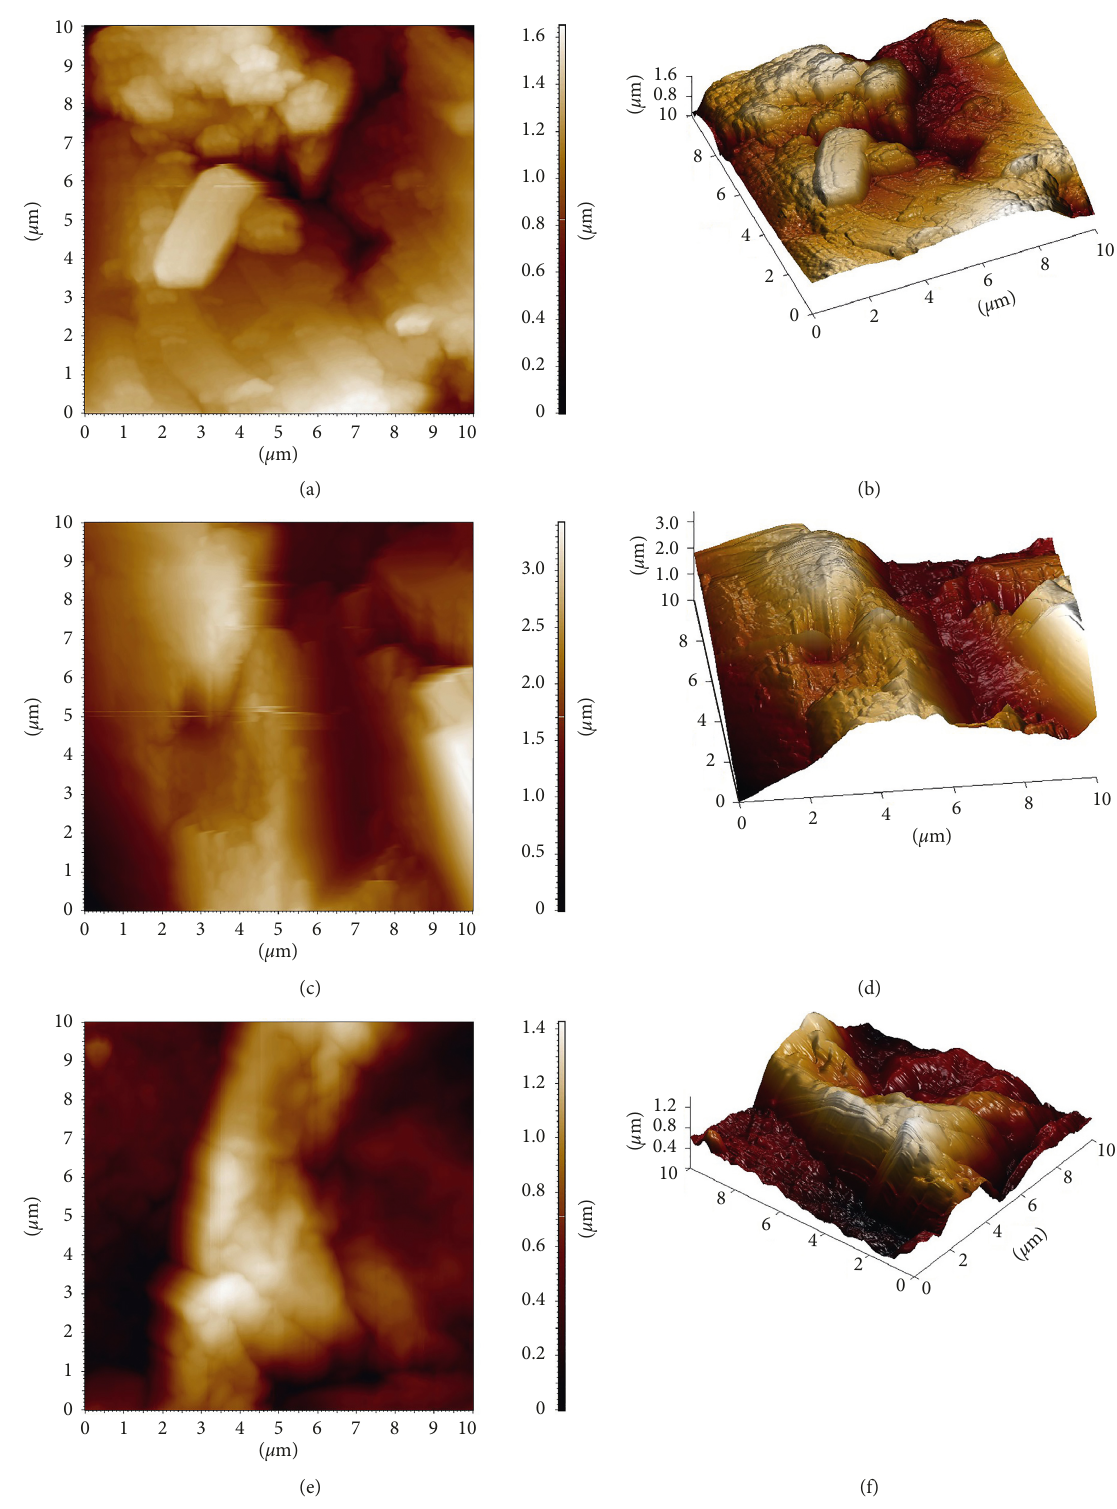
Figure 4: The AFM 2D (on the left) and 3D topography images (on the right) of specimen 100 (a, b), 50 (c, d), and 0 (e,